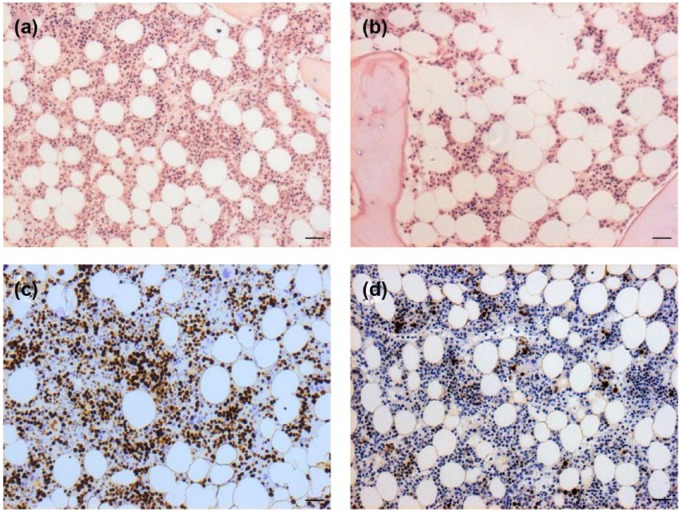
Cellularity and cell proliferation in marrow from subjects with MS. (a,
b) MS trephine with cellularity and (c, d) cell proliferation as
determined by Ki67 expression (a, c) considered normal for age
(50 years) and (b) hypocellular (40% instead of 60%) with (d) reduced
proliferation (20%) from a participant aged 39 years. Scale bar:
100 µm.